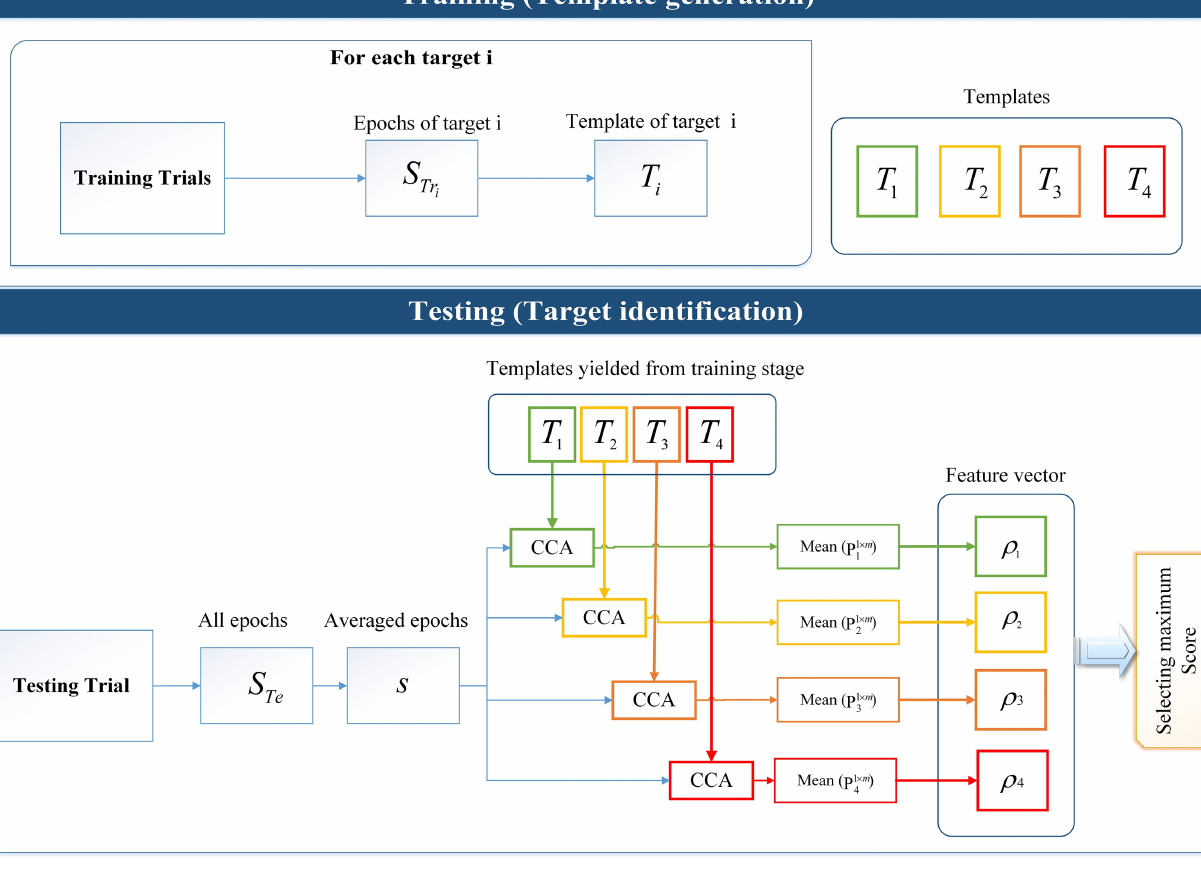
Fig 10. Schematic representation of using CCA for template generation and target identification. Template generation included extraction of epochs for each target and averaging them to generate templates. Target identification included extraction of epochs for testing trial and calculation of the canonical correlation of generated templates from training stage and averaged epochs for generating the feature vector and finally the maximum value of feature vector were selected.